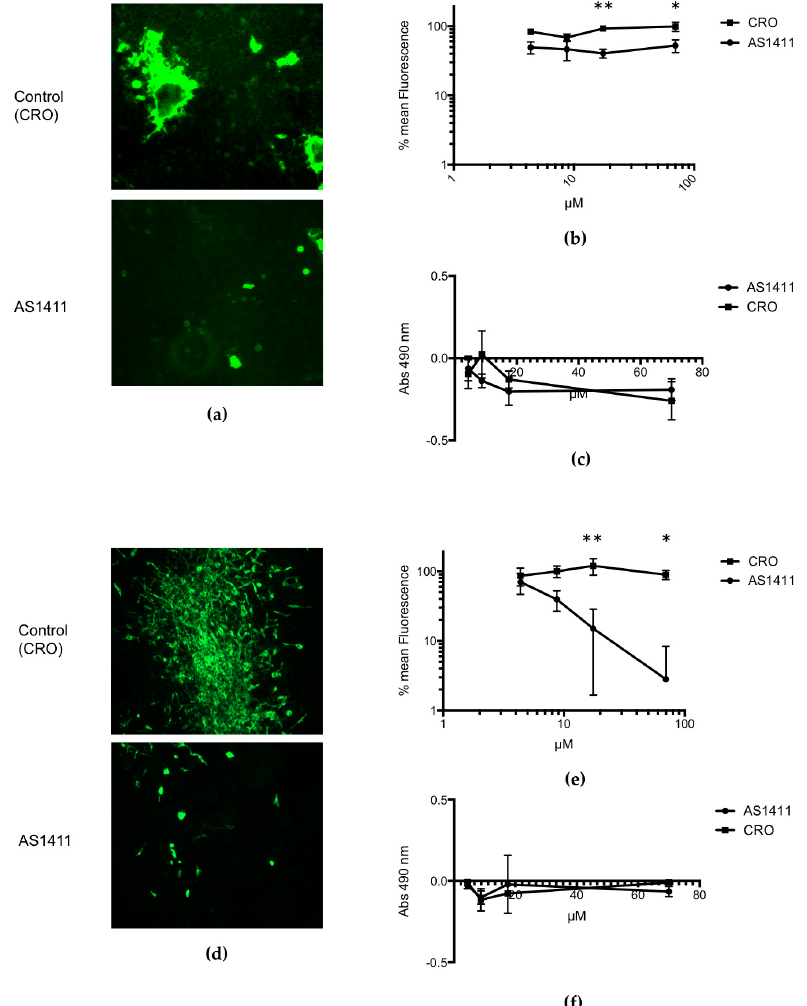
Figure 3. In vitro data demonstrating the efficacy of AS1411 in reducing viral infection. Fluorescence images of HEp-2 cells ( a ) or of MDCK cells ( d ) treated with 17.5 μ M AS1411 (bottom) or control (CRO) compound (top), given 24 h after RSV challenge. With AS1411 treatment, the reduction in fluorescence signal is due to reduction in the overall number of RSV-infected cells; HEp-2 cells ( b ) or MDCK cells ( e ) infected with virus (MOI = 0.1) 24 h prior to treating with AS1411/CRO ( n = 6). A total of 17.5 μ M of AS1411 is sufficient to obtain a 60% decrease in RSV fluorescence 24 h after it is added to HEp-2 cells ( b ) (** p = 0.0039 and * p = 0.01 using Bonferroni procedure; 2-way ANOVA, p < 0.0001). Quantities of 17.5 µ M and 70 µ M of AS1411 are sufficient to obtain a 87% and 97% decrease in RSV fluorescence in MDCK cells ( e ), respectively (** p = 0.003 and * p = 0.03 respectively using Bonferroni procedure; 2-way ANOVA, p < 0.0001). The MTS assay (Promega TM , Madison, WI, USA) was performed for both HEp-2 ( c ) and MDCK ( f ) experiments in parallel to assess for cellular toxicity. No difference is seen between AS1411 and CRO in terms of cellular proliferation/health, indicating there was no significant cytotoxicity (2-way ANOVA, with no significant difference between each set of points using Bonferroni